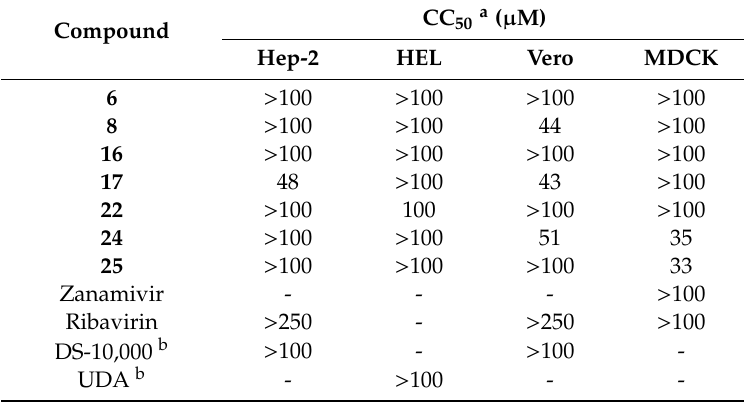
Table 2. Cytotoxicity of compounds 6 , 8 , 16 , 17 , 22 , 24 and 25 in four mammalian cell